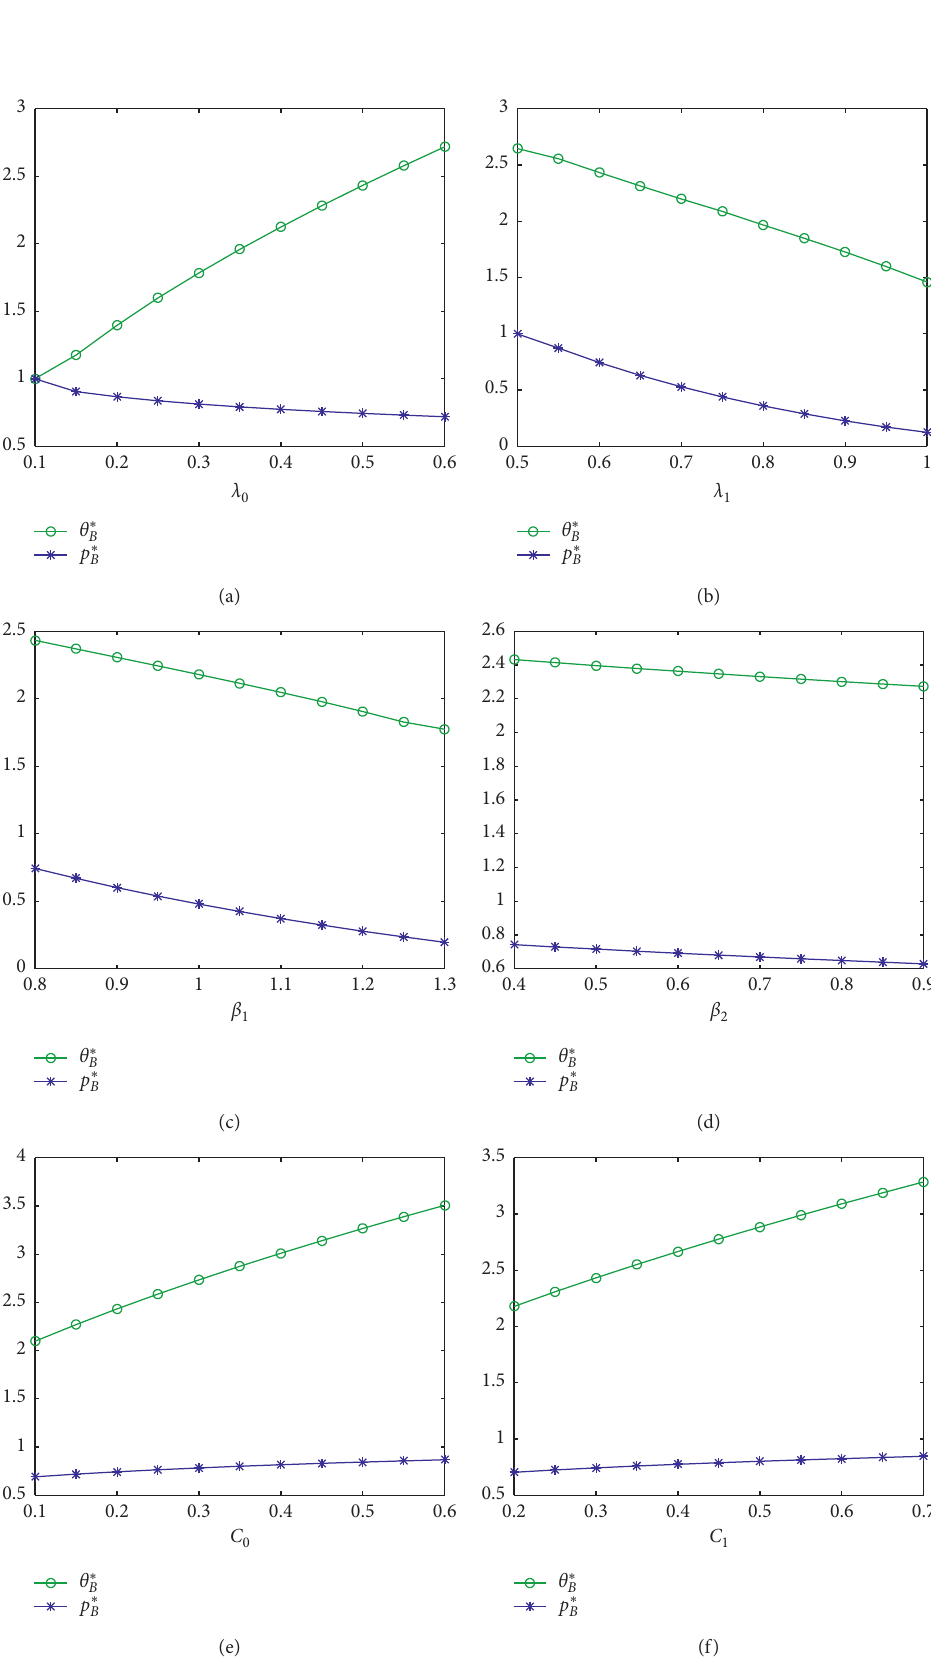
Figure 5: The sensitivities of θ ∗ � 0 . 8 , and β 0 . 6 , β 1 C � 0 . 2 , C � 0 . 3 , λ 0 1 � 0 . 8 , and β 0 . 6 , β 1